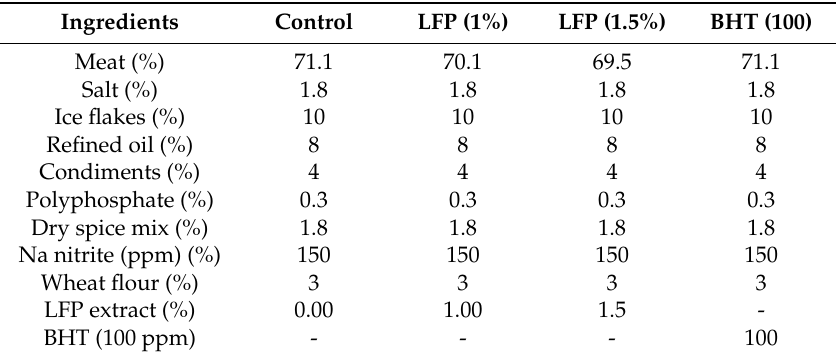
Table 1. Sheep meat nuggets’ formulation prepared with litchi fruit pericarp (LFP) extract and butylated hydroxytoluene